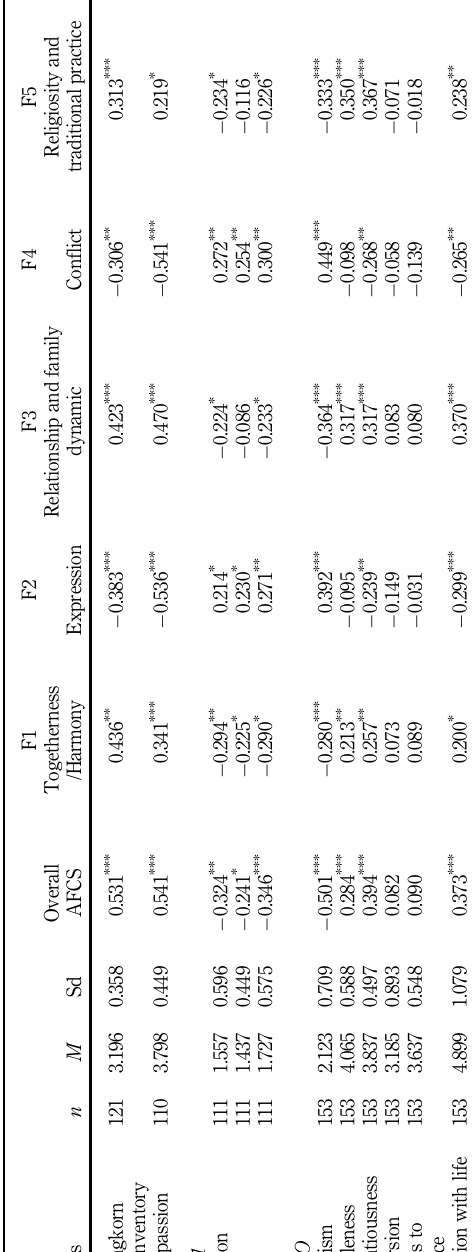
Table 6. Correlations